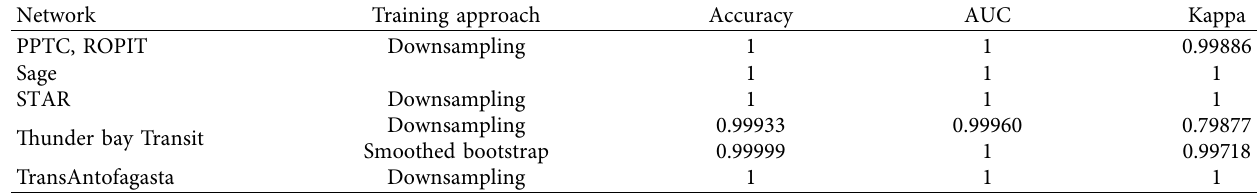
Table 6: In PPTC, ROPIT, Sage, STAR, Thunder Bay Transit, TransAntofagasta networks, the average estimation of accuracy, AUC, and kappa calculated over the k times in which the model was trained.